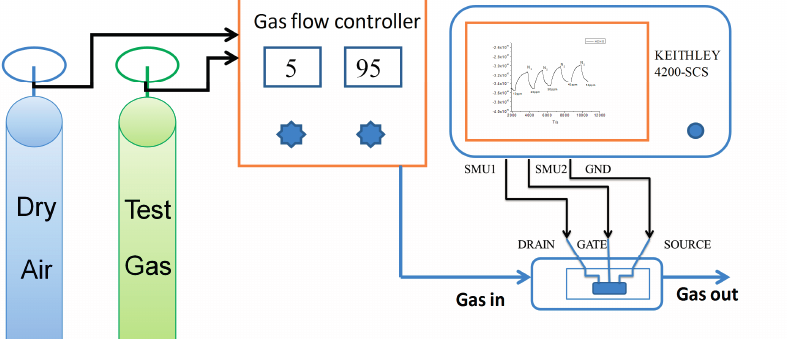
Figure 2. Schematic illustration of the experimental